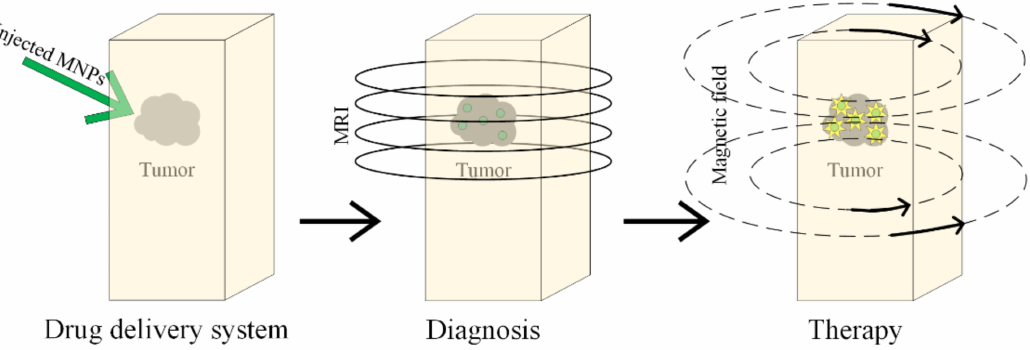
Figure 15. Diagnosis and treatment of the tumor based on MNPs, using magnetic